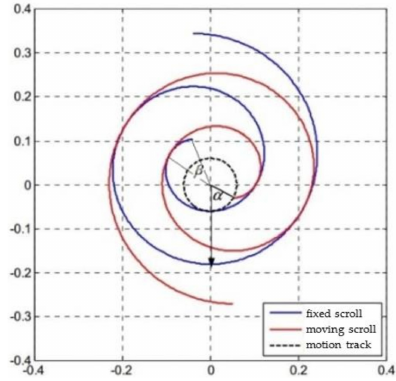
Figure 1. Geometry diagram of scroll